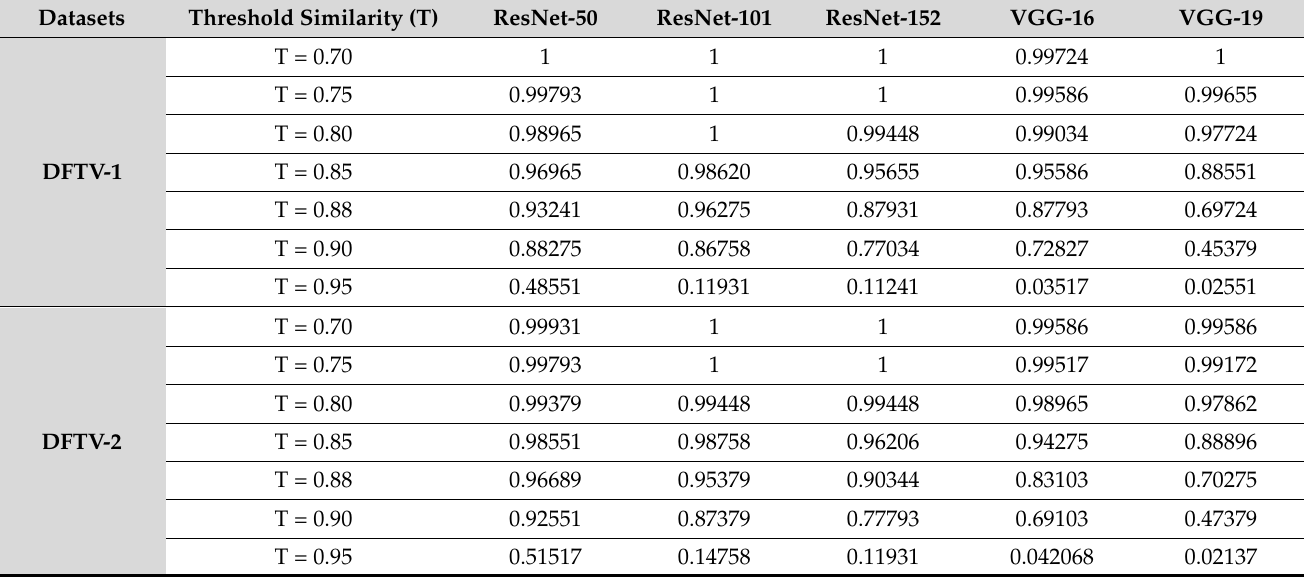
Table A3. Mean average precision (MAP) @ K = 5 of CNN